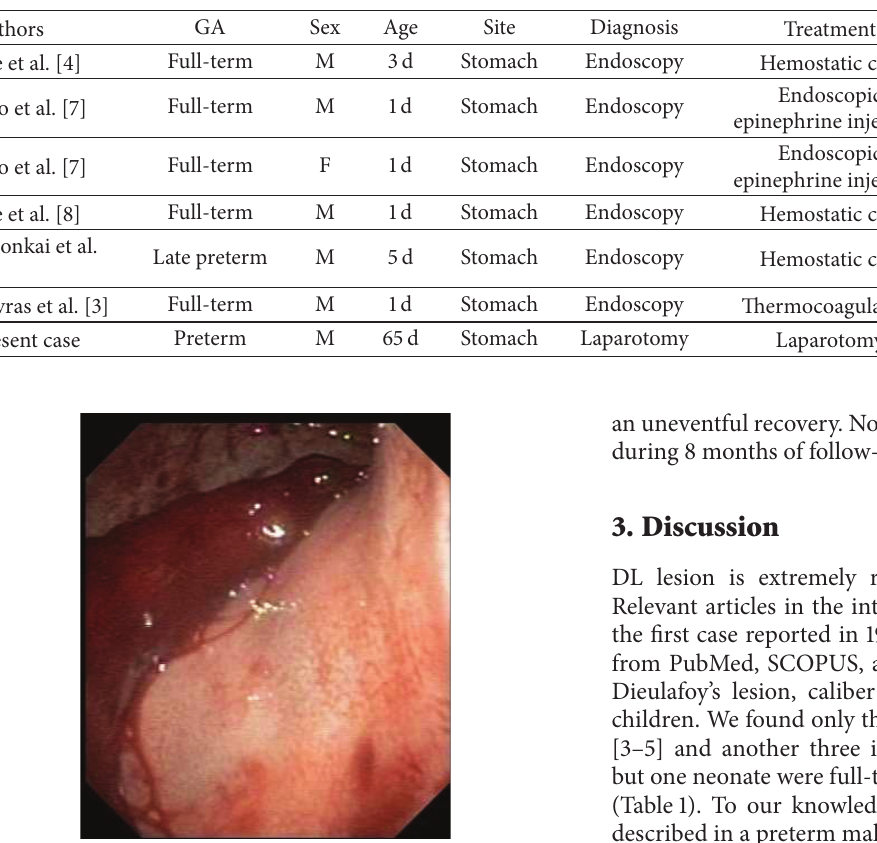
Table 1: Published cases of Dieulafoy’s lesion in the neonatal age group.